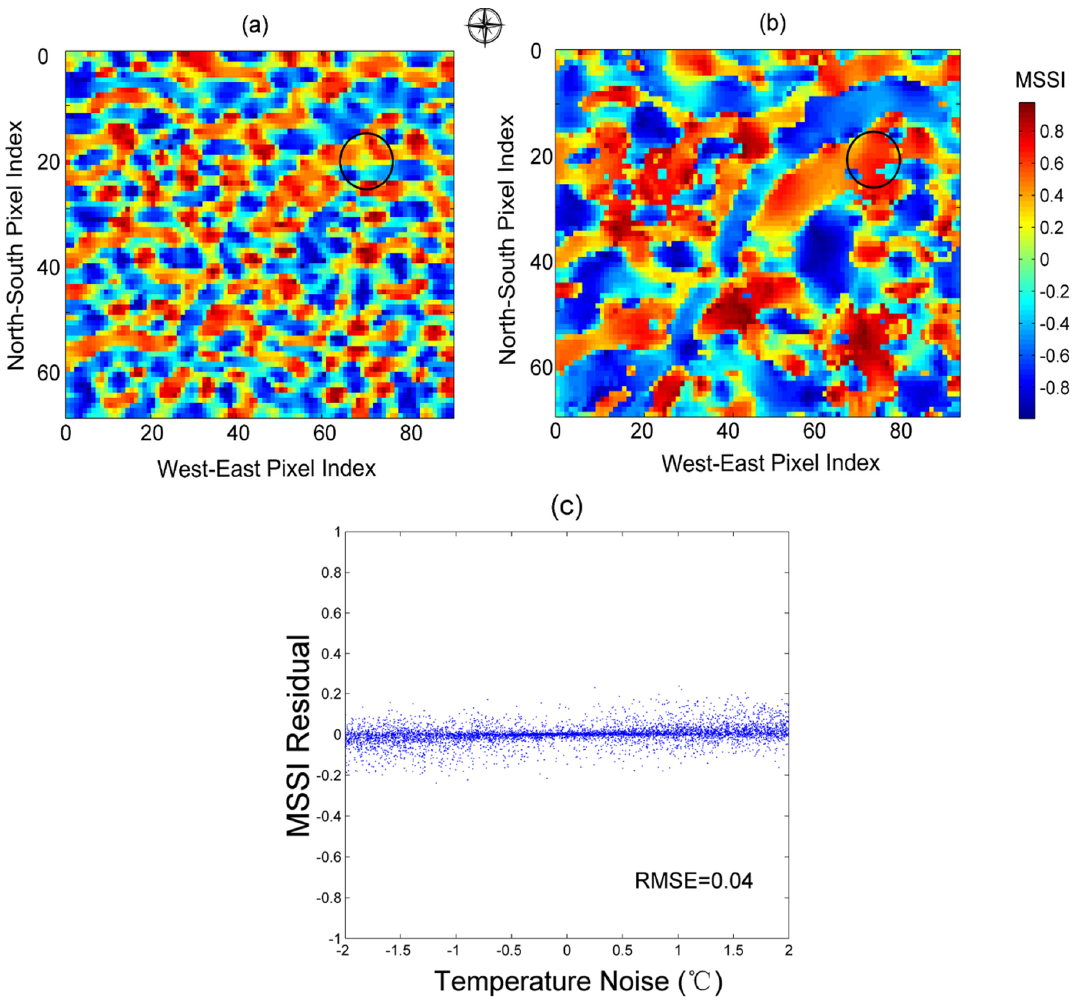
Figure 5. The Shape Index of the latent LST pattern. ( a ) The regular SI of the latent LST pattern at 13:30 on 27 July 2012; ( b ) The corresponding MSSI. The reference area is denoted by the black circle; ( c ) The robustness of the MSSI against noise.